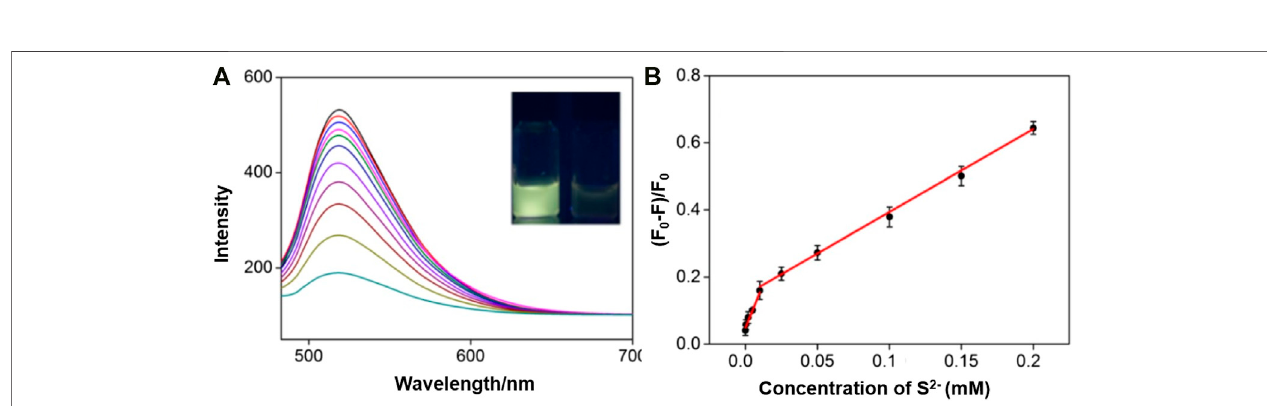
FIGURE 5 | The relative fl uorescent ratio of IL-GQDs in the presence of different single or mixed (the mixture of all ions on the x axis) anion (A) or cation. (B) AA (20mM) is added in case of mixed cations.